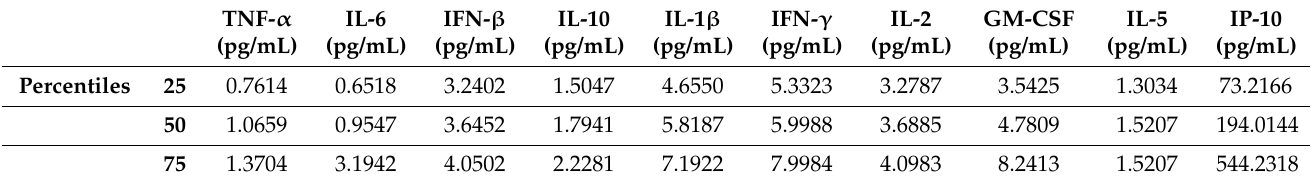
Table 2. Interquartile range of the cytokine concentrations excreted in human breastmilk of all tested subjects.